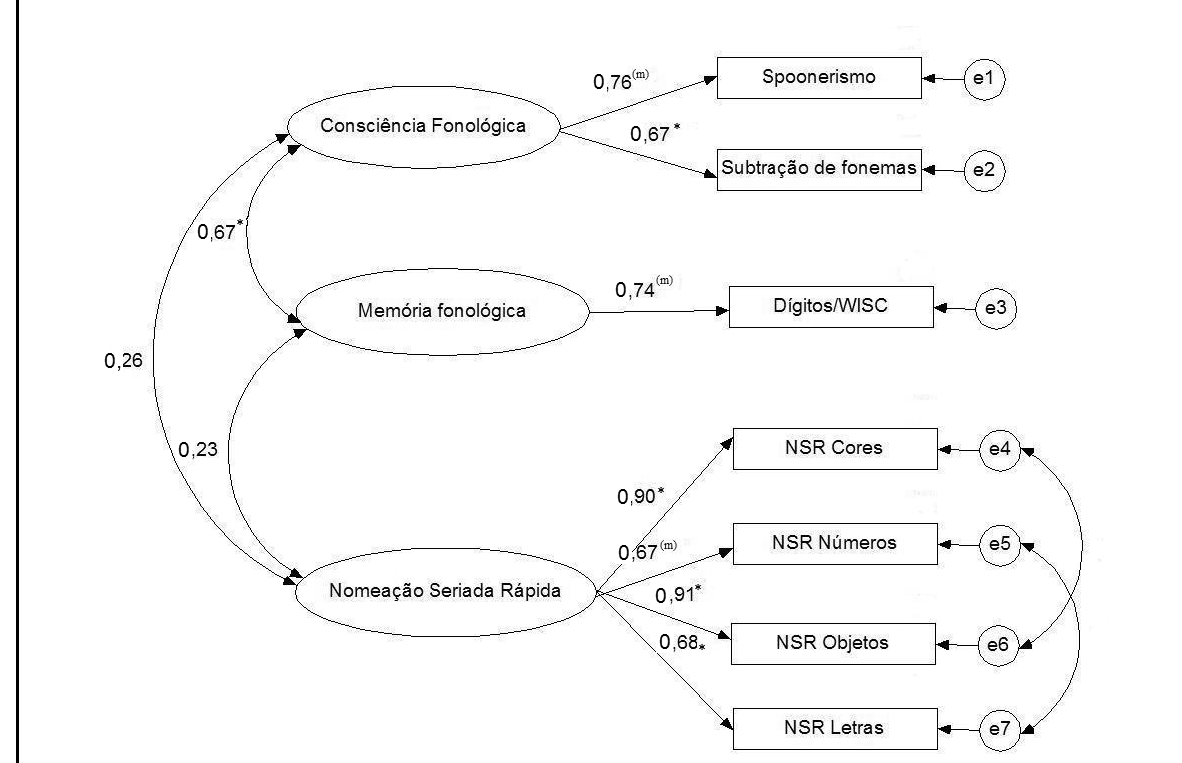
Figura 3. Diagrama do modelo com três fatores (representação da proposta de Wolf & Bowers, 1999). Nota : NSR = nomeação seriada rápida; (m) = métrica; * p < 0,05.